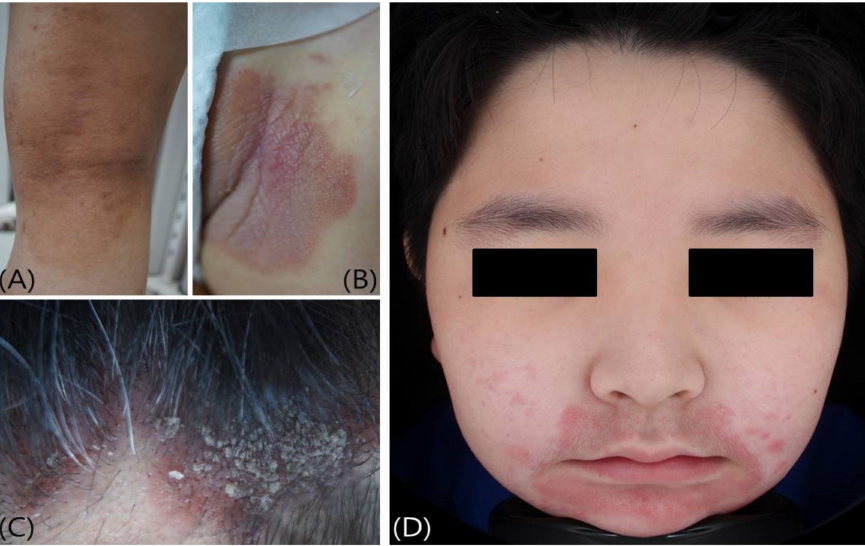
Figure 1. Common disorders in children and adolescents that cause itching: ( A ) Atopic dermatitis, ( B ) Psoriasis, ( C ) Seborrheic dermatitis, and ( D ) Contact